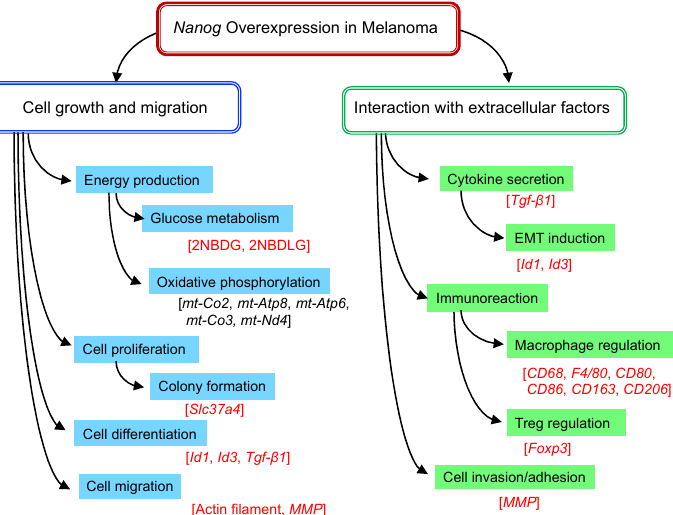
Figure 4. Nanog-dependent phenomena observed in melanoma. Relevant genes, proteins, or probes are described in brackets. Red letters in brackets indicate those analyzed by experiments; black letters in brackets indicate those analyzed only by transcriptome